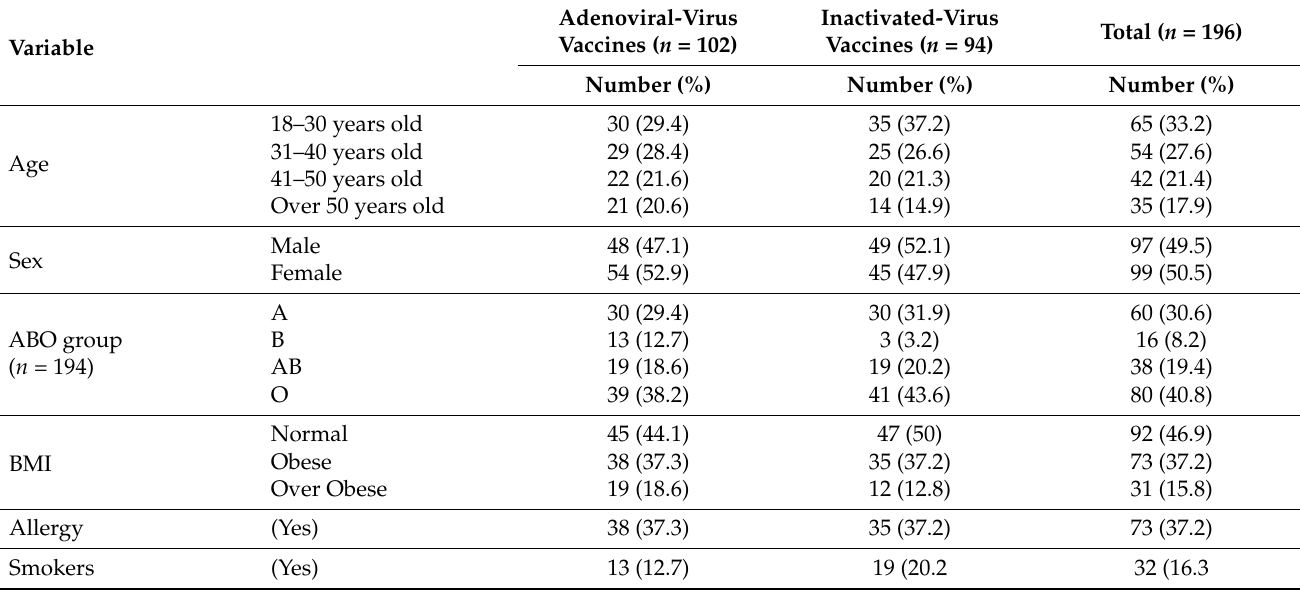
Table 1. Demographic and anamnestic characteristics of the study